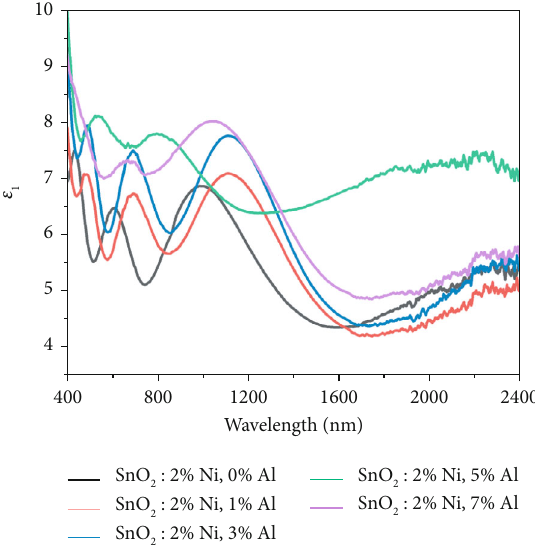
Figure 10: Real part of dielectric constant of Al-Ni-codoped SnO thin fi lms.